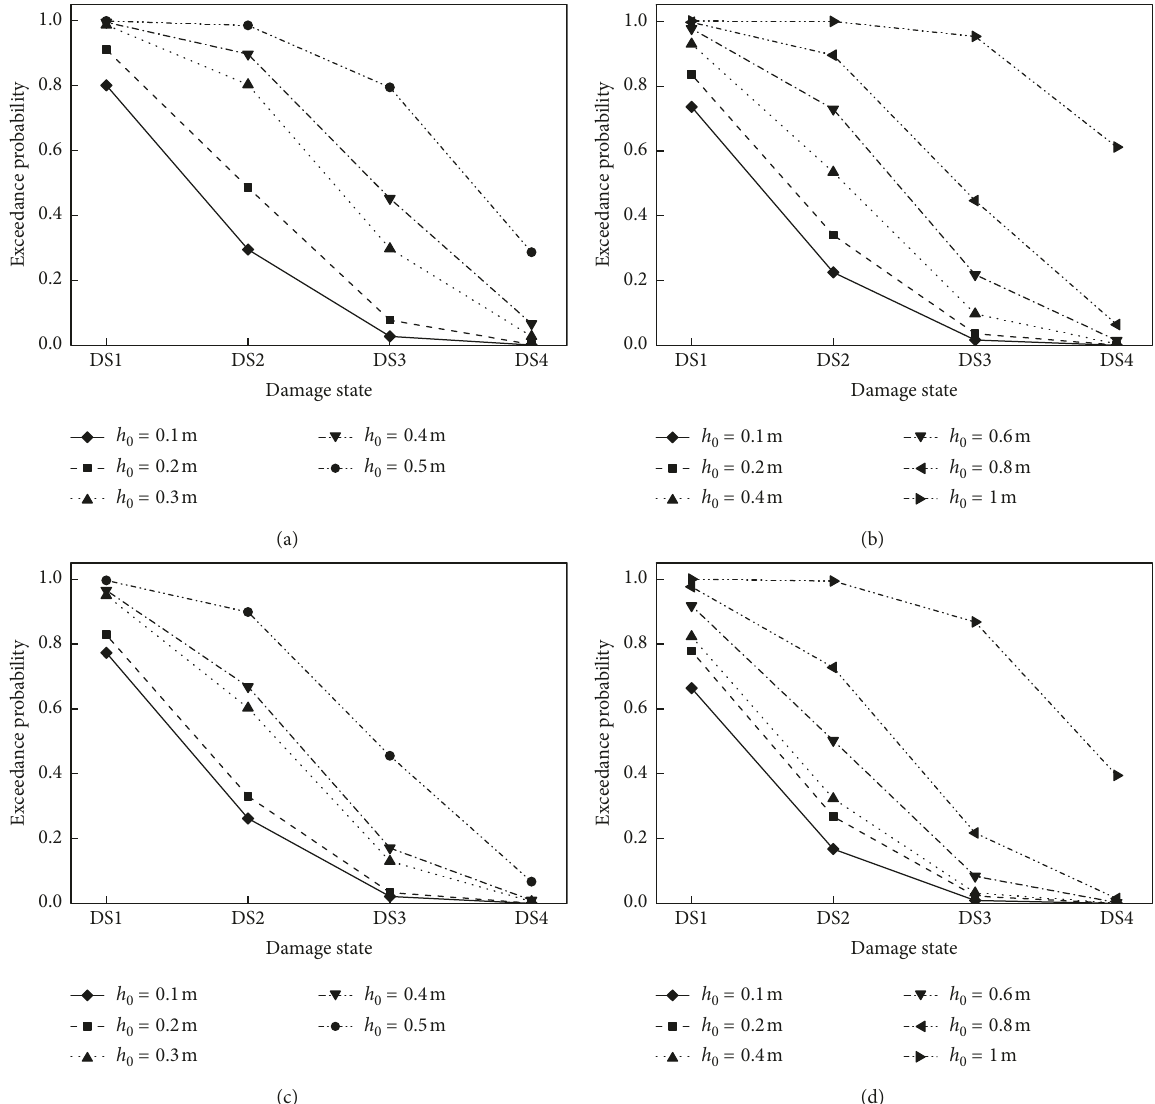
Figure 9: Structural residual displacement when K 100kN/m with different damping constant, PGA (cid:31) DS2, DS3, and DS4 are defined by the structural residual displacement in Table 2). (a) μ 0 1 , h . 0m, C 0.005, r 0.0m 50kN s/m. (c) μ 0 (b) μ 0 1 (cid:31) 1 (cid:31) (cid:31) (cid:31) · . 0m, C h 100kN − 1 (cid:31) 1 (cid:31) ·